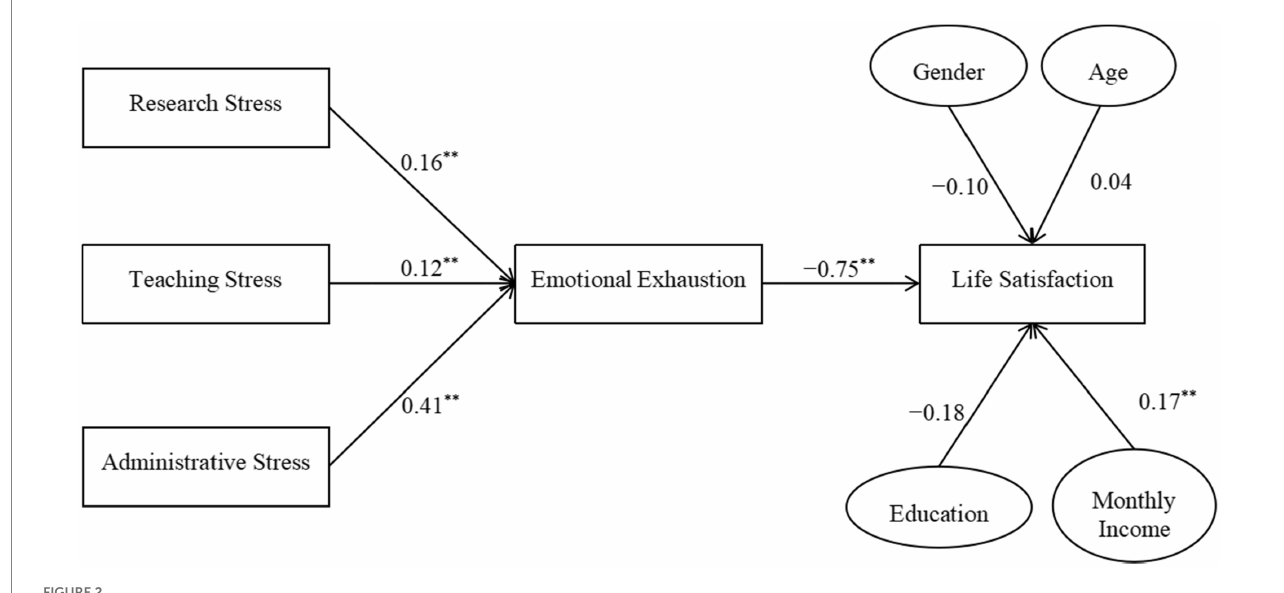
FIGURE 2 Path analysis coefficients of hypothesized model. ** p < 0.01.